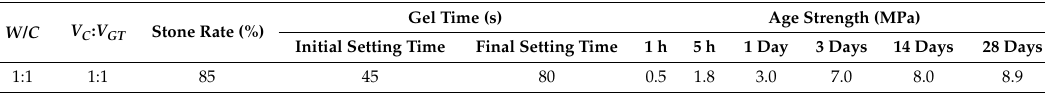
Table 2. Parameters of the C-GT slurry.